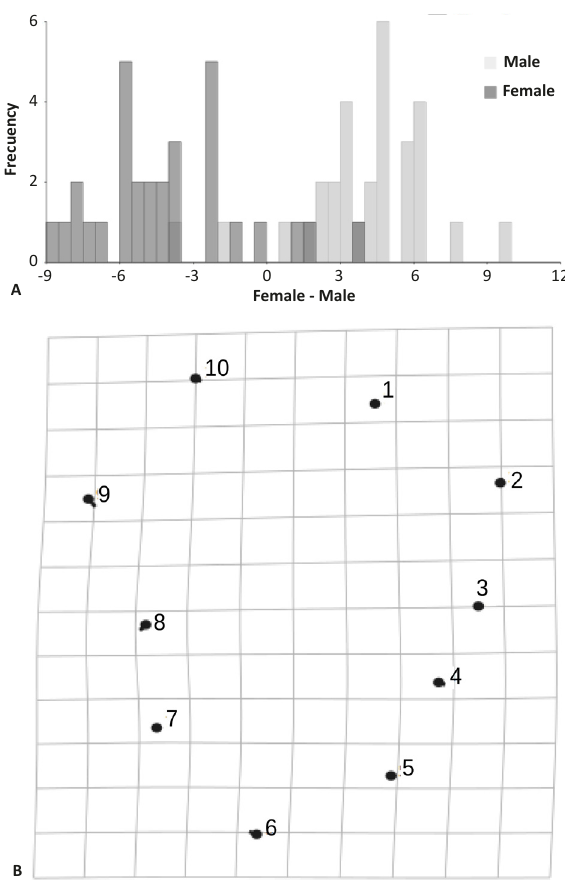
Figure 3. Discriminant analysis for 60 Aedes albopictus pupae specimens: A - histogram with the values of the discriminant scores for groups (females and males) and B - the thin-plate spline deformation grid with the differences between females and males.